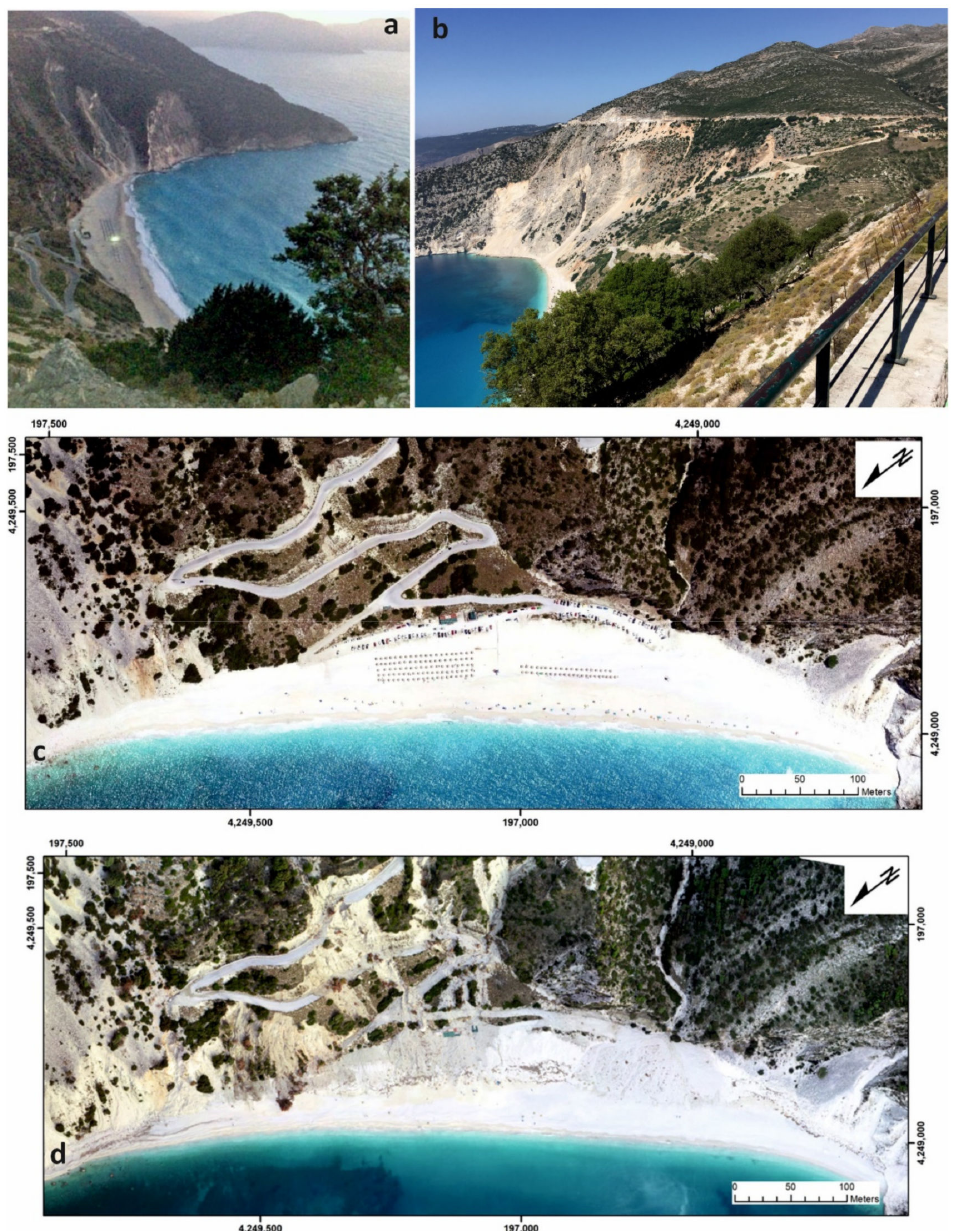
Figure 8. Selected geosites on Kefalonia island, for coding see Figure 4: ( a , b ) the spectacular Myrtos beach (K01); ( c , d ) the main geomorphic changes at the popular Myrtos beach, can be clearly seen by comparing the orthoimages before ( c ) and after ( d ) the Sept. 2020 Medicane Ianos disaster (Vassilakis et al., 2021). Photos courtesy ( a ) D. Marketou-Galari and ( b ) M.V.